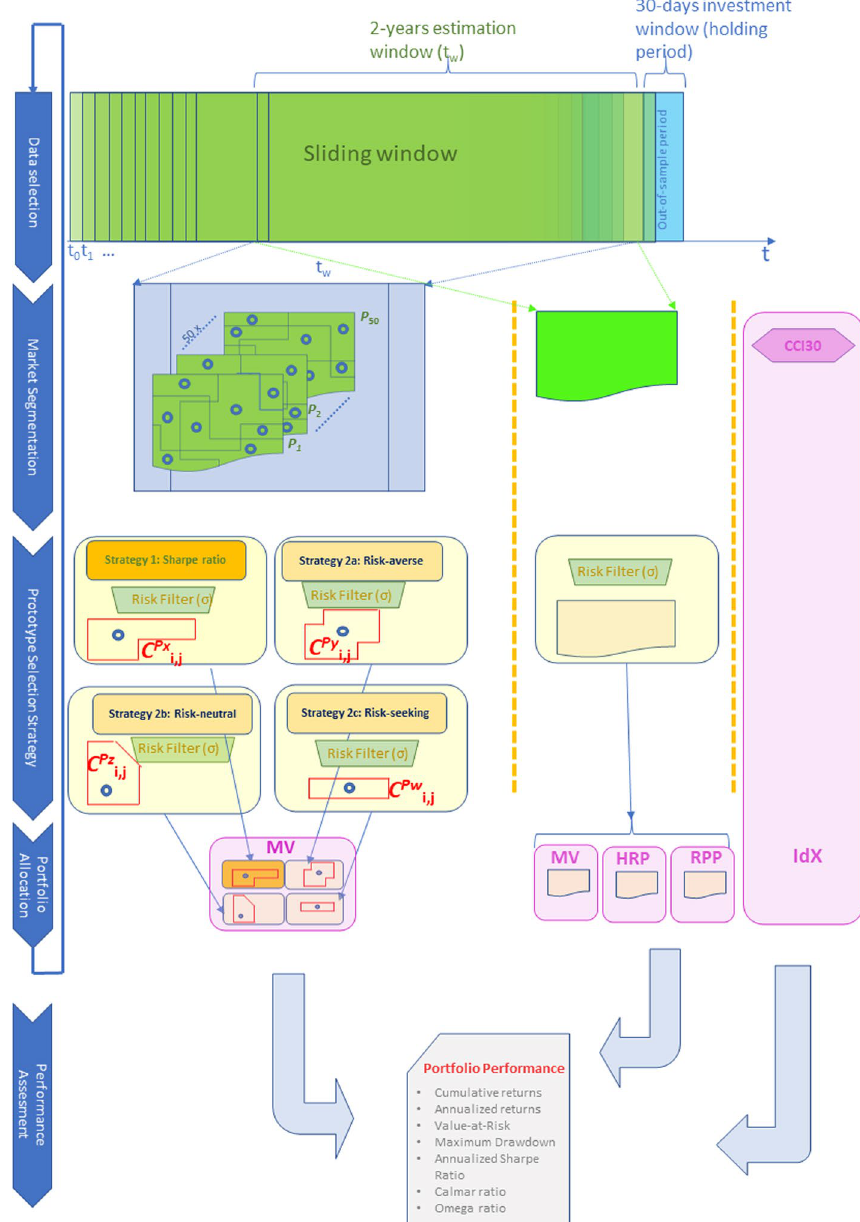
Fig. 1 Flowchart of the algorithm for portfolio